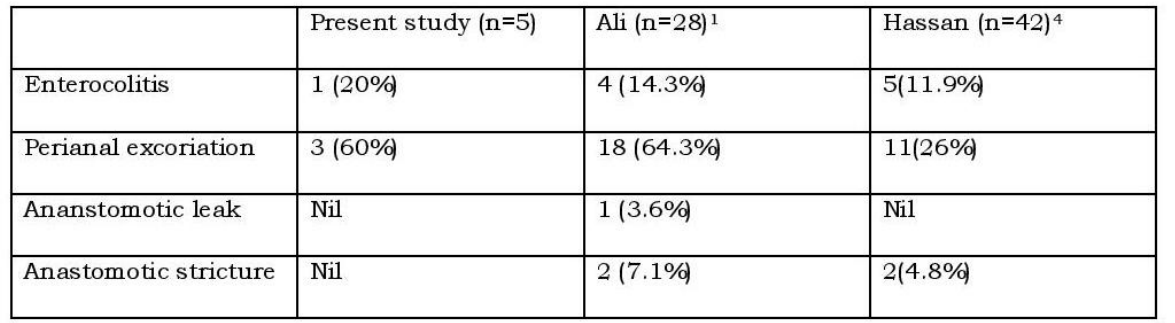
leak or retraction of anastomotic site. Three were managed with frequent application of zinc